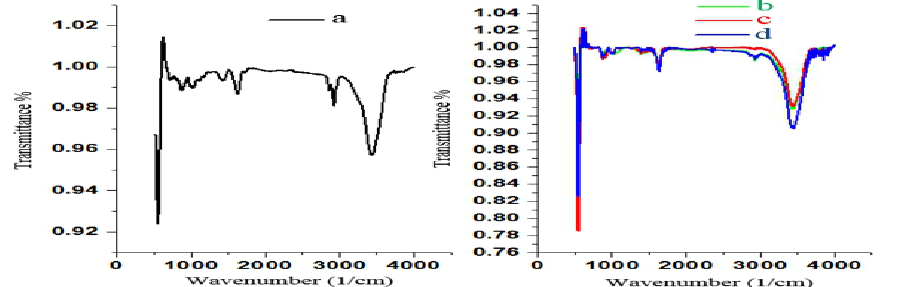
Fig. 3. FTIR Diffractogram a) ZnO b) WO-ZnO 0.5% c) WO-ZnO 1% d) WO-ZnO